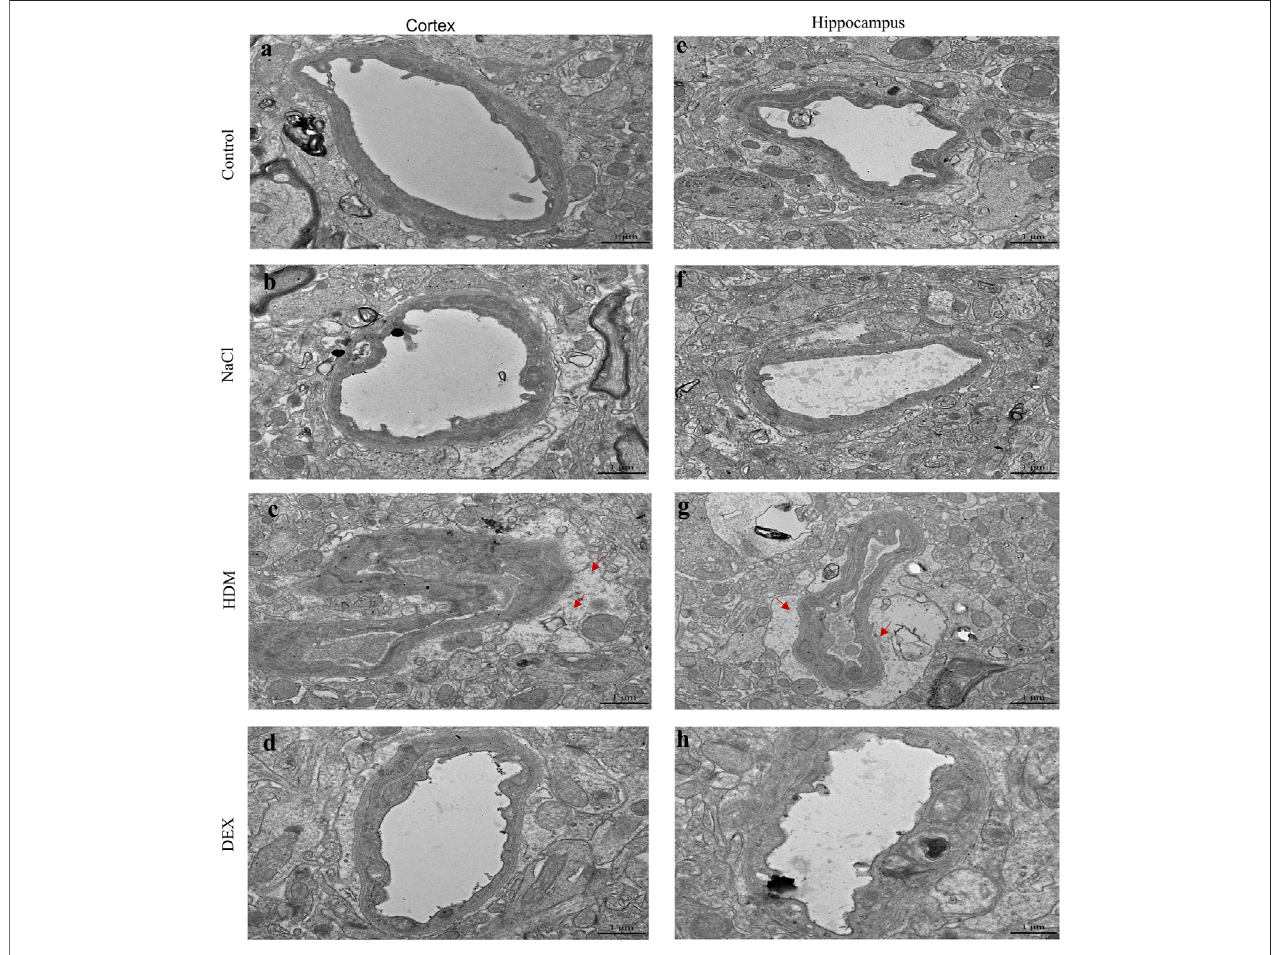
FIGURE 6 | The blood vessels in the hippocampus and cortical area of the brain of mice in the HDM group were edema. (a – d) Blood vessels in the cortex of mice. (e – h) Blood vessels in the hippocampus of mice. The red arrow points to the area of vascular edema in the hippocampus and cortical area in the HDM group.